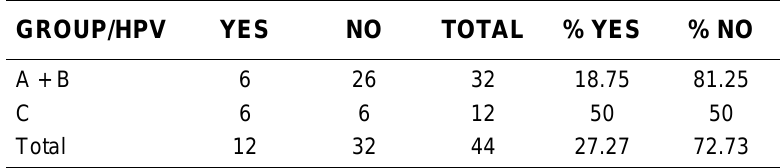
Presence of HPV DNA in Biopsied Fragment of Vestibular Papillomatosis in Groups A and B vs. Group C from the PCR and Statistical